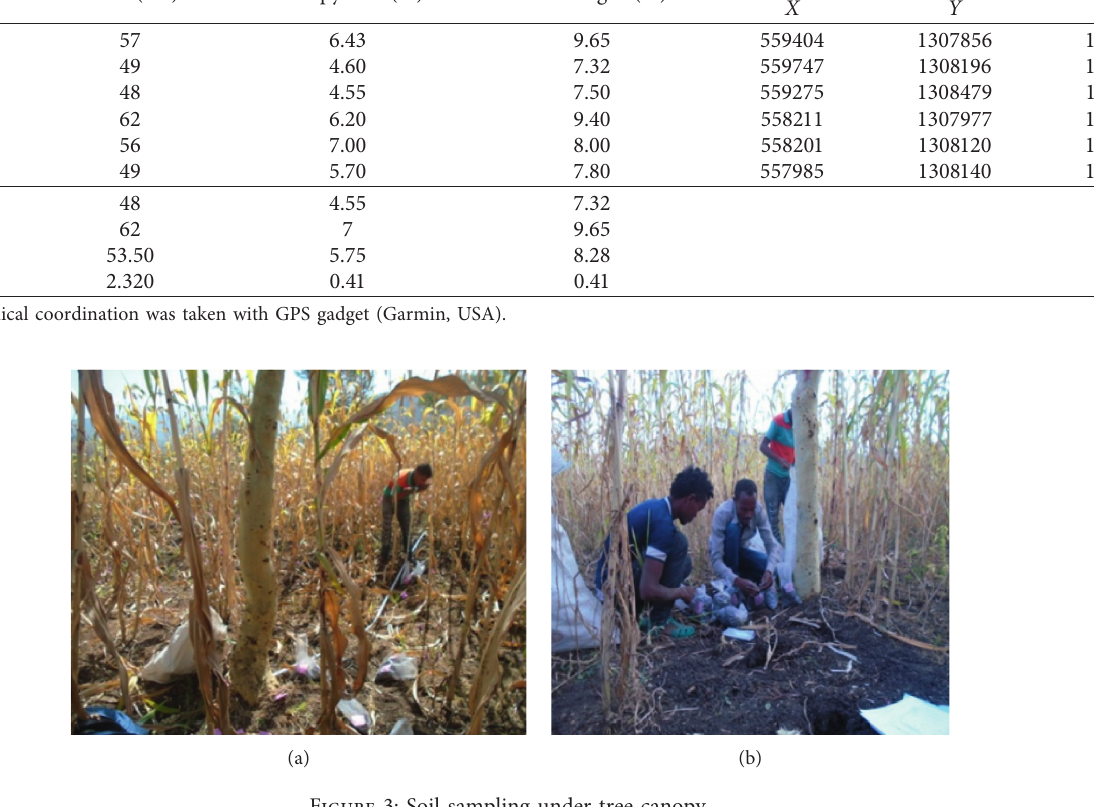
Table 1: DBH, canopy size, and height of selected Acacia seyal trees for the study. Plot no.